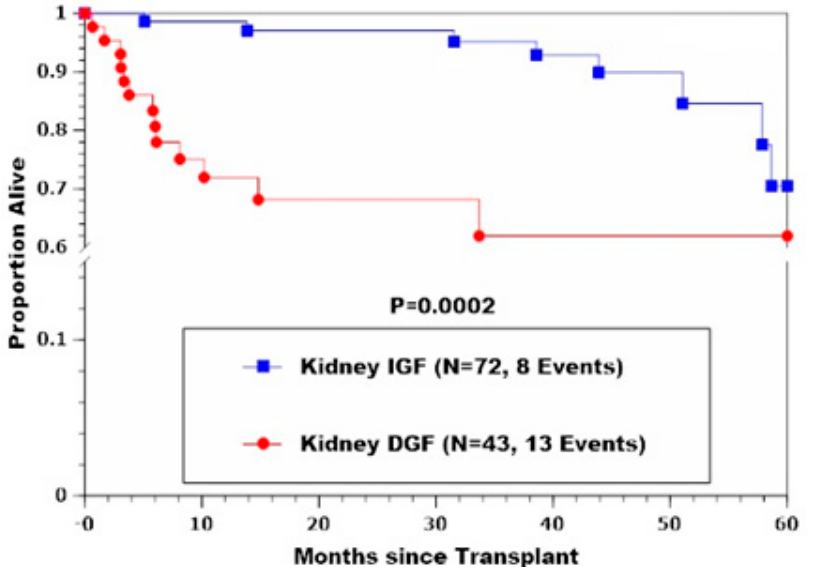
Figure 2. Patient survival in kIGF and kDGF recipients showing inferior survival rates among kDGF patients, particularly during the first few years post-CLKT.